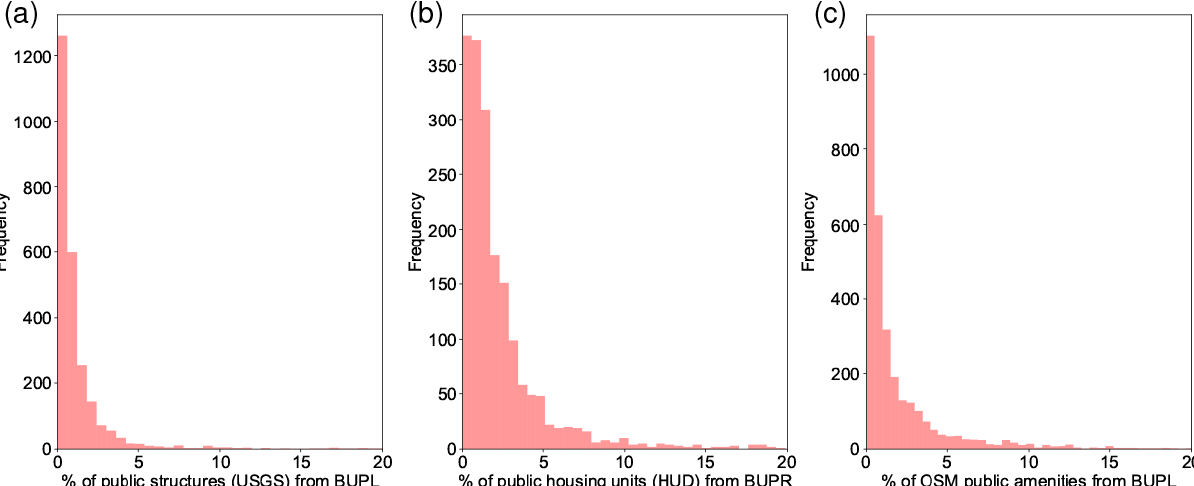
Figure C1. Assessment of omission errors introduced by lacking information on publicly owned buildings in ZTRAX: frequencies of county- level proportions of (a) public structures, (b) public-housing units, and (c) public amenities, referred to the respective county-level sums of BUPRs or BUPLs. Note that the y -axis range differs by